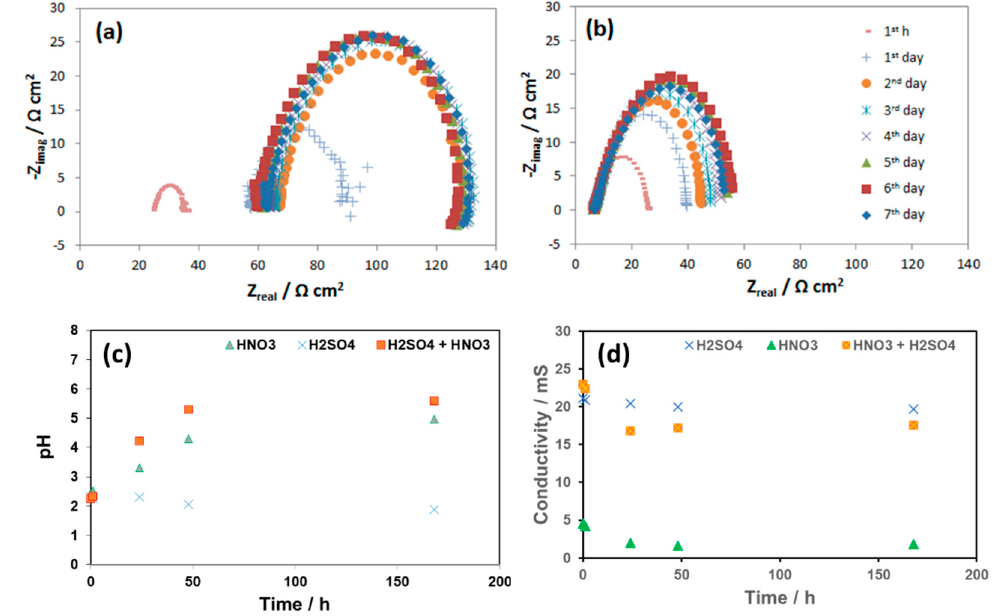
Figure 12. The change in free corrosion potentials of L360NB exposed to CO 2 saturated 0.114 M H 2 SO 4 and 0.0184 M HNO 3 contained condensates.